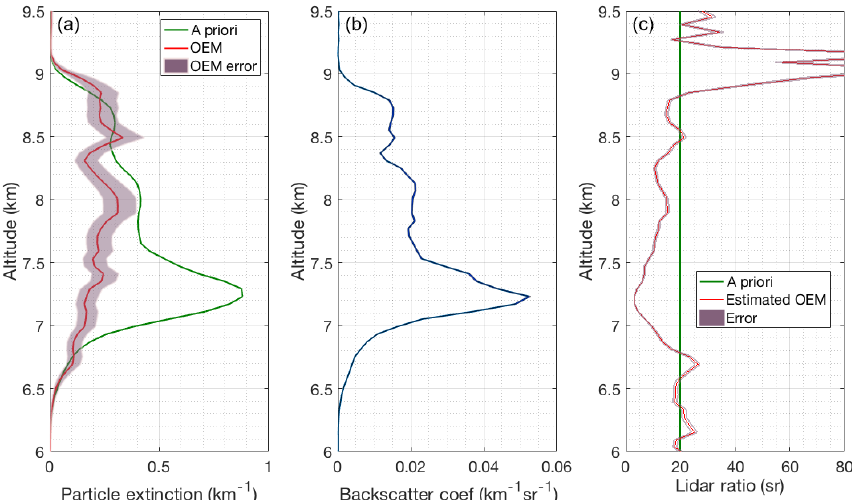
Figure 16. (a) Retrieved particle extinction (red) and the a priori particle extinction used in the OEM (green). (b) Backscatter coefficient calculated from the nighttime RALMO measurements on 5 July 2011 with of a cirrus cloud present at 6km height. (c) Lidar ratio used to determine a priori particle extinction (green) and the estimated lidar ratio using the OEM-retrieved particle extinction (red).